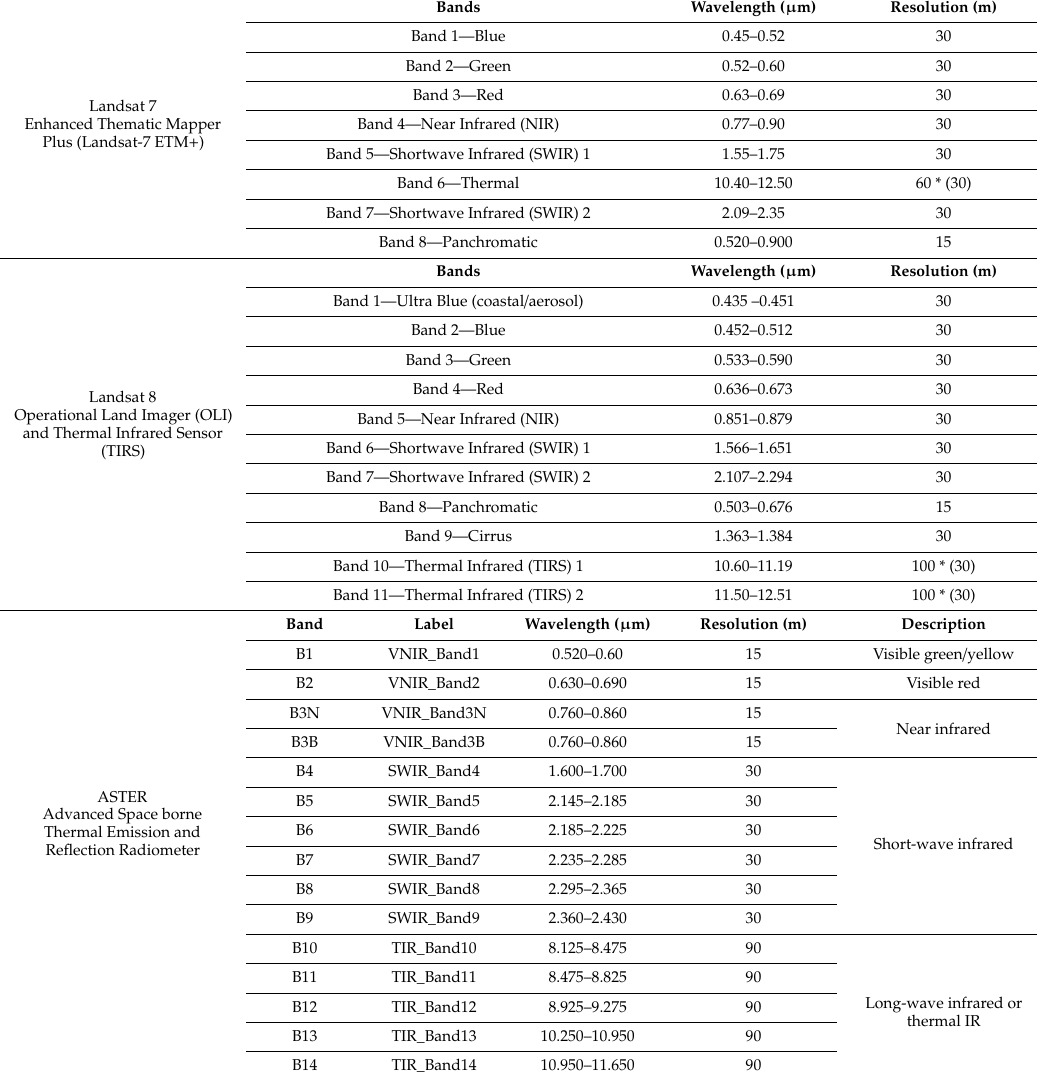
Table 1. Technical characteristics of the Landsat-7 ETM + , Landsat-8 and ASTER remote sensing sensors